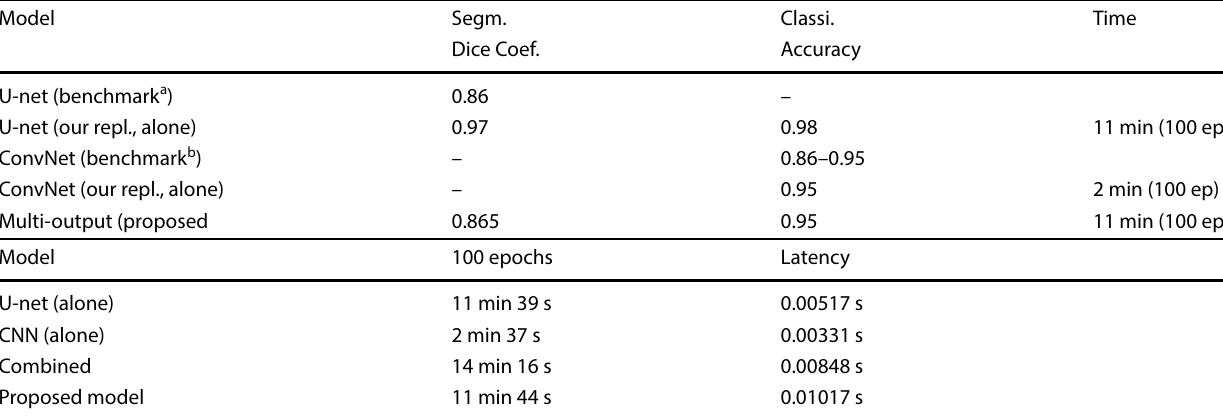
Table 3 Segmentation and classification